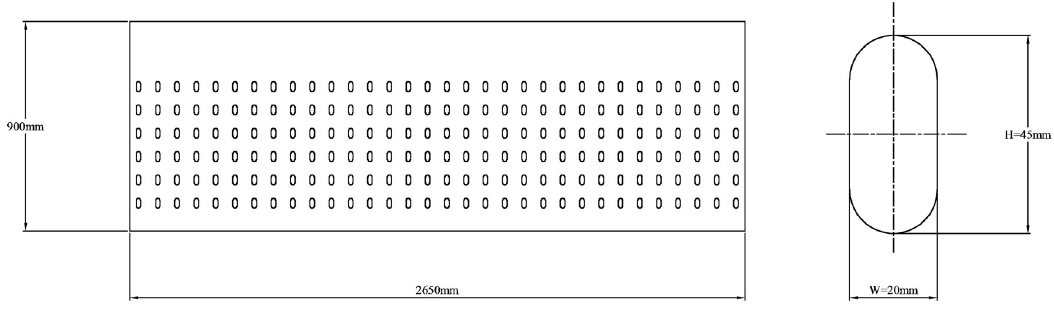
Fig 4. Air inlet